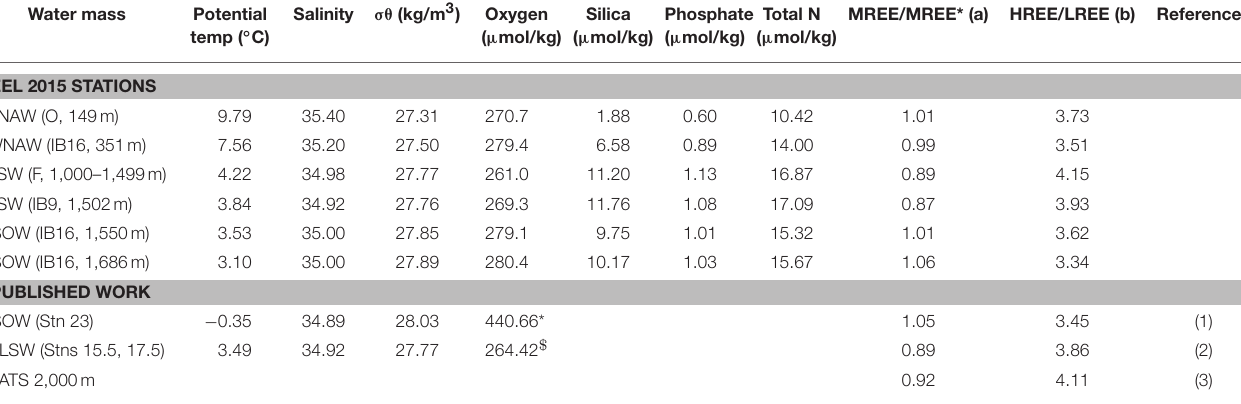
TABLE 1 | Water mass properties of selected stations and depths along the EEL 2015 cruise, with comparison to end-member water masses in published work. Water mass